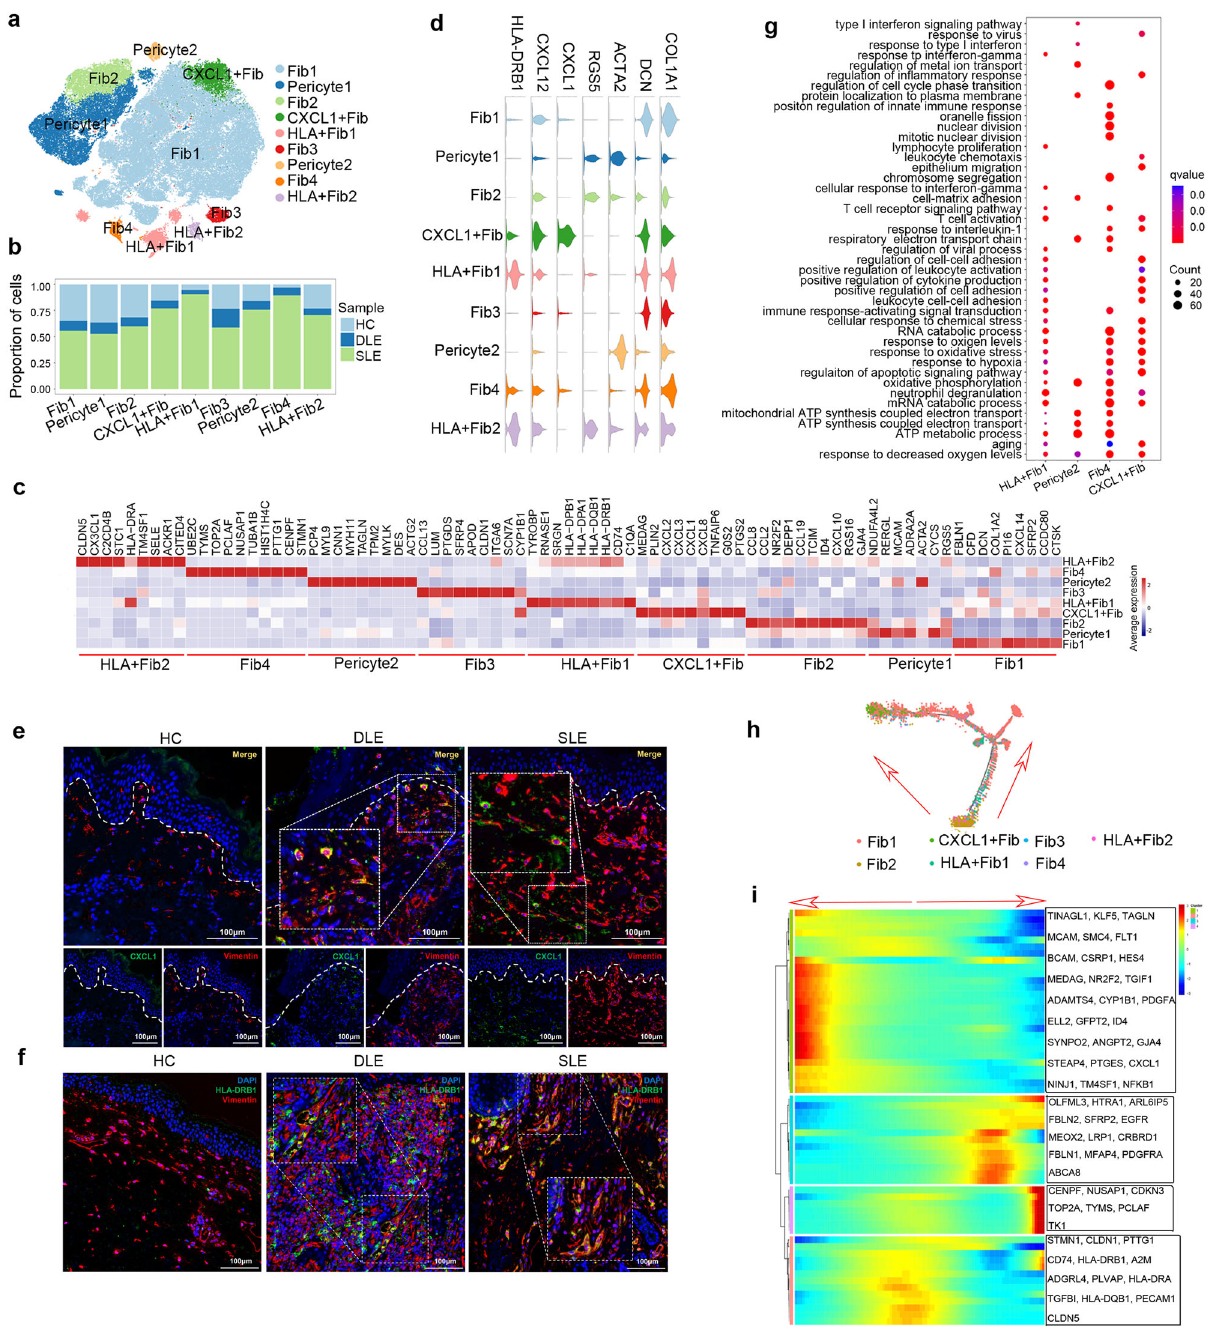
immuno fl uorescence staining of Vimentin represents the cell type of fi broblasts. Scale bar: 100 µ M. Data are representative of 3 independent experiments. g A bubble diagram shows the Gene Ontology (GO) biological process (BP) terms of expanded fi broblast subtypes. h Trajectory plot shows pseudotime trajectory analysis of selected fi broblast subtypes. The arrow indicates the possible differ- entiation direction. i Heatmaps show gene clusters with the differentiation state that were predicted by pseudotime trajectory analysis. The arrow indicates the possible differentiation direction. Source data are provided as a Source Data fi